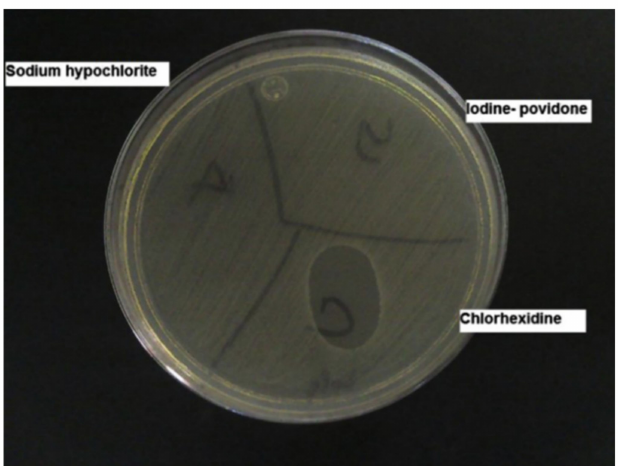
Figure 2. Agar plate in which the substantive effect can be seen. The plate was divided into 3 zones; in each one an antiseptic was tested. Only the zone in contact with skin washed with chlorhexidine showed an inhibition zone. Reproduced with permission from [71], American Jornal of Infection Control, 2013. Chlorhexidine gluconate 2% w / v in 70% v / v ethanol was effective in eradicating multidrug-resistant Acinetobacter baumannii with biofilms (MDRAB-Bs) with no MDRAB-Bs detected after only 1 min of contact (Figure 3)